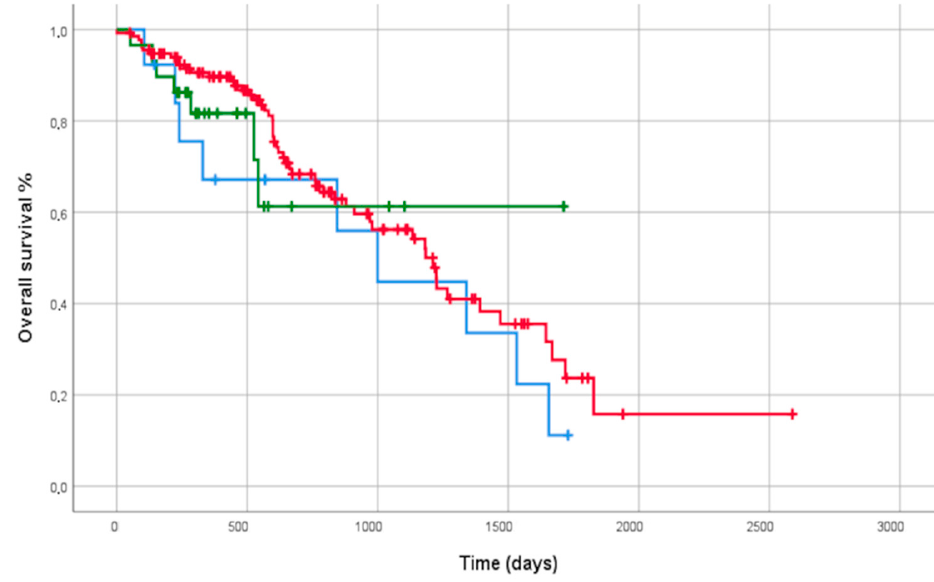
Figure 1. Comparison of overall survival curves of patients with IPF ( red line ), PF-ILD ( green line ) and FPF ( blue line ) through Kaplan–Meier